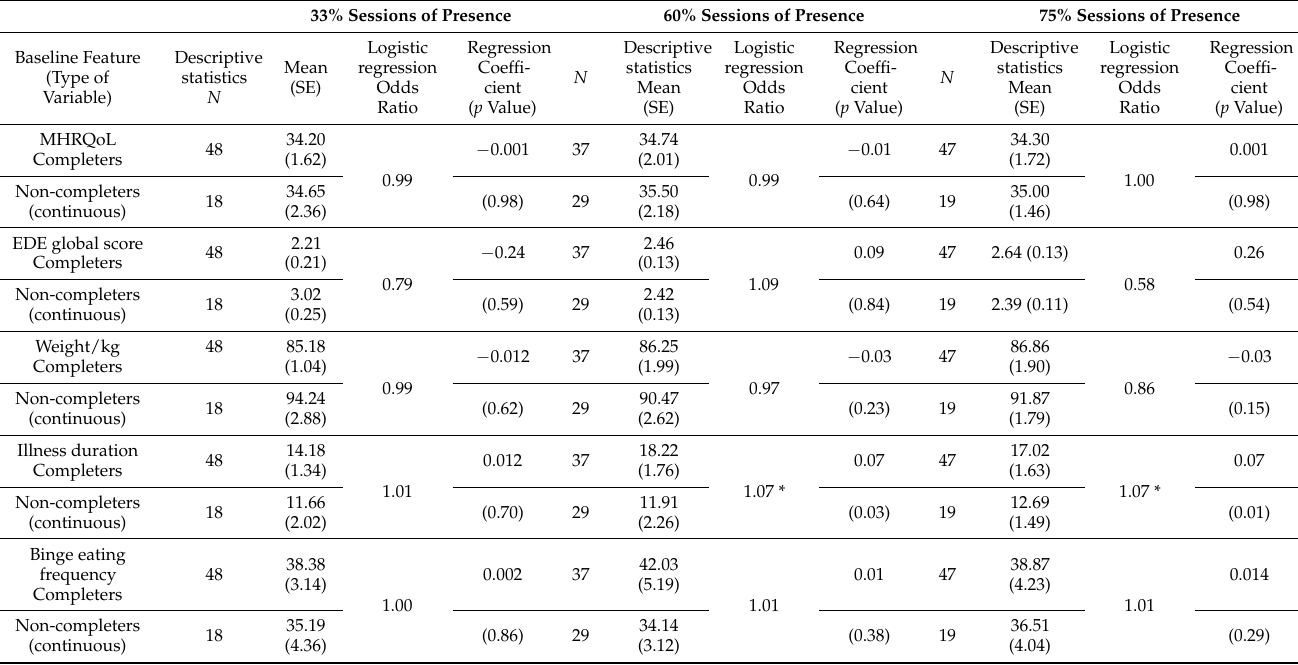
Table 4. Results of descriptive statistics at baseline and logistic regression for presence of 33% sessions, 60% sessions and 75% sessions, respectively among those with